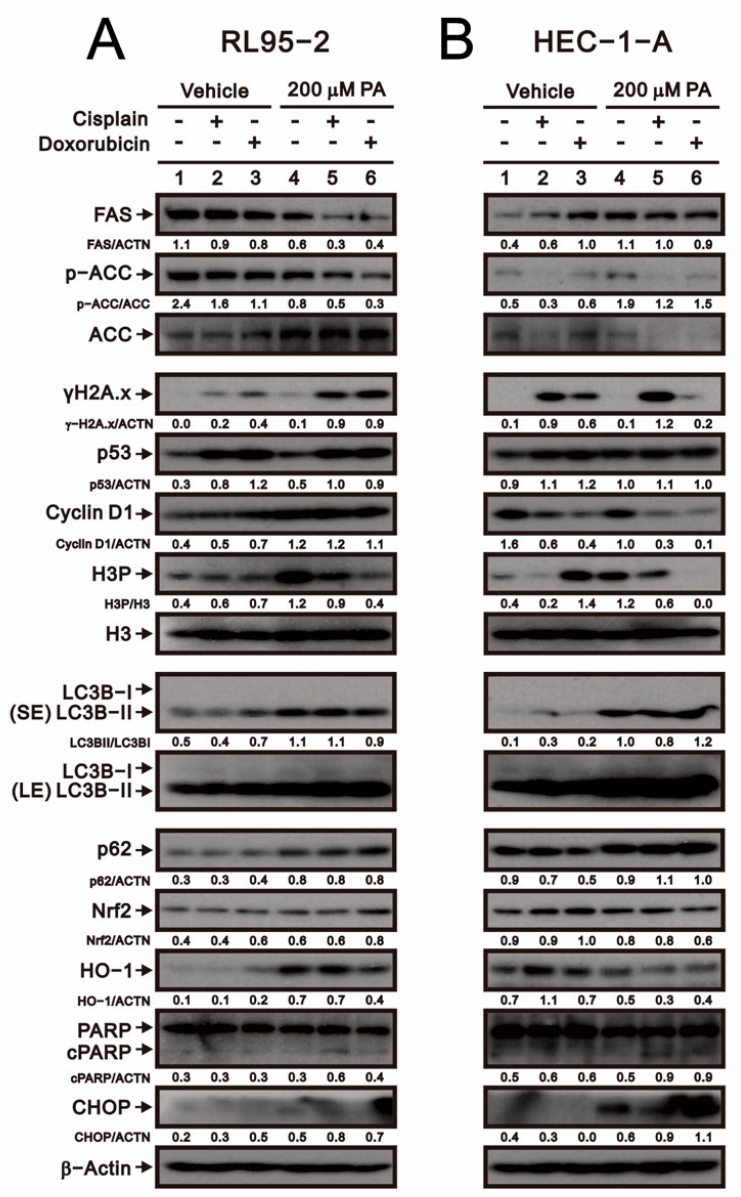
Figure 3. Effects of palmitate with cisplatin or doxorubicin on protein expression in RL95-2 and HEC-1-A cells. ( A ) RL95-2 cells were incubated for 24 h with 200 µ M palmitate plus 5 µ M cisplatin